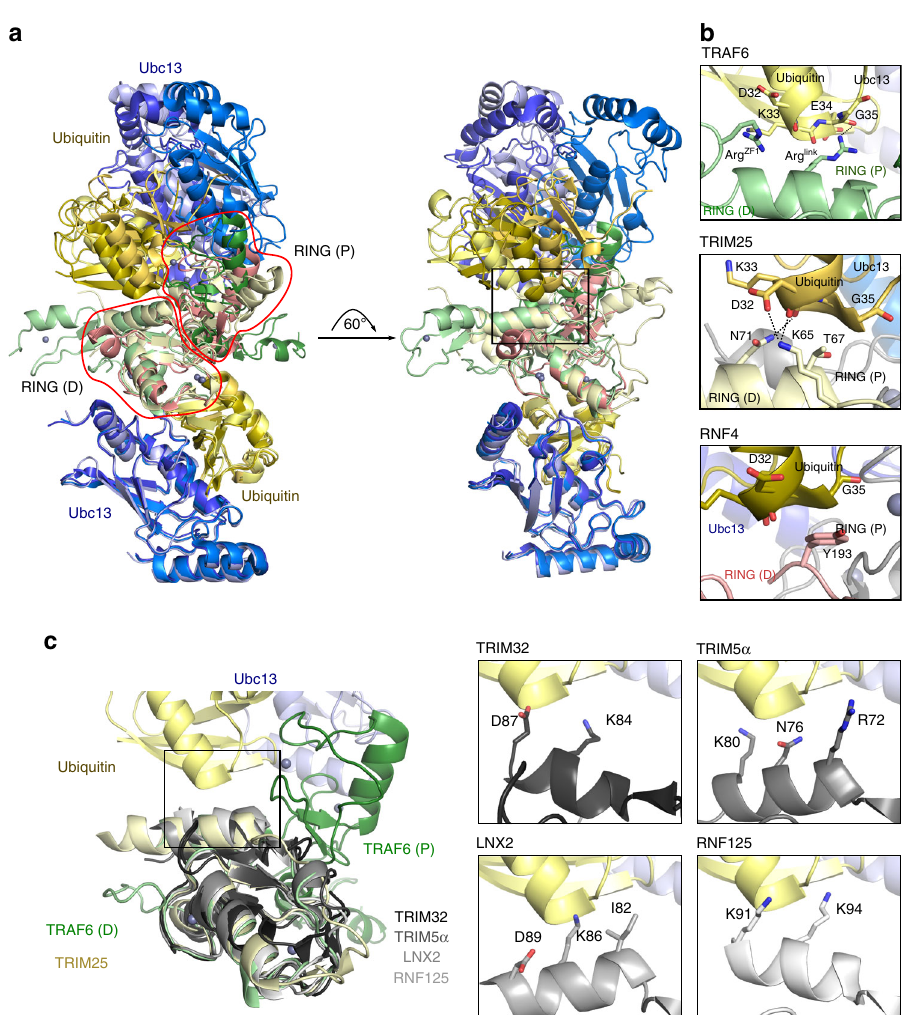
Fig. 5 Conserved interactions stabilise the position of ubiquitin in RING-Ubc13~Ub complexes. a The distal (D) RING and bound E2~Ub conjugate from TRIM25-Ubc13~Ub (PDB: 5EYA) and RNF4-Ubc13~Ub (PDB: 5AIU) were overlaid onto TRAF6-Ubc13~Ub. Zinc atoms are shown as purple spheres. (D) refers to the distal RING, (P) proximal. The RING domains are indicated with red outlines. b A detailed view of the contacts between the distal RING and ubiquitin that stabilise the closed conformation. Predicted hydrogen bonds are indicated by dashed lines, and sticks are coloured by atom type (oxygen, nitrogen and sulphur atoms are coloured red, blue and yellow, respectively. Carbon atoms are coloured the same as ribbon). c An overlay of four RING domains (PDBs: TRIM5 α 4TKP; TRIM32 5FEY; LNX2 5DIN; RNF125 5DKA) on the RING from Dr RZ 3 highlighting the conserved position of the C-terminal alpha helix. On the right is a detailed view of the putative ubiquitin-gripping residues from these RING domain structures. RNF125 is modelled as a dimer, though it is monomeric in PDB